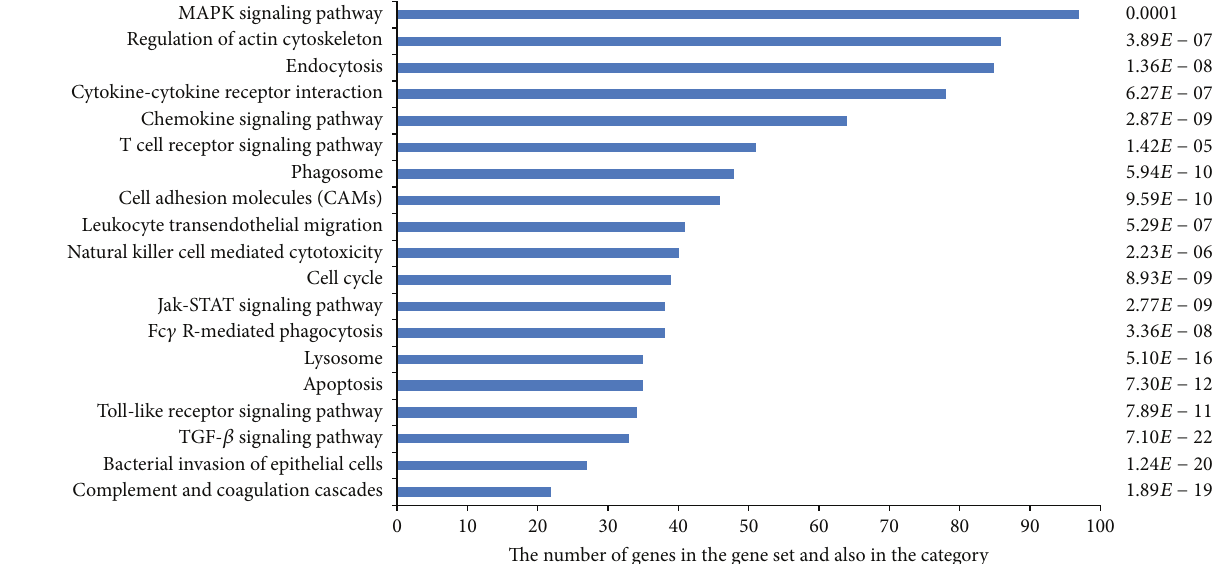
Figure 3: Pathway analysis of 3 downregulated miRNAs, miR-494, miR-139-3p, and miR-6069 according to KEGG function annotations.